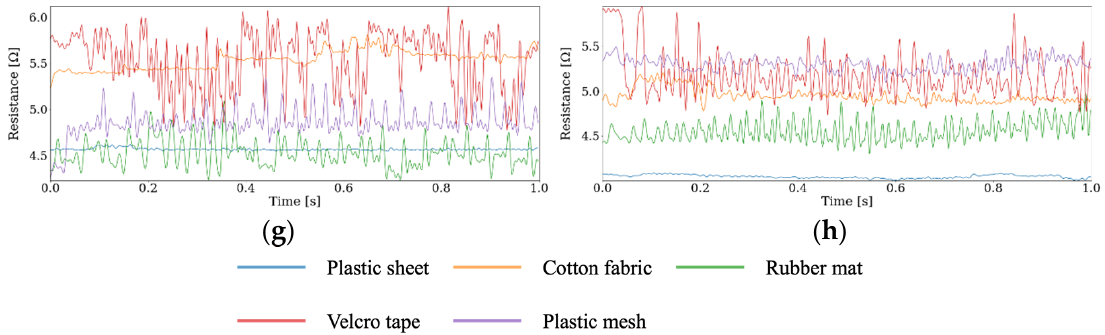
Figure 10. Examples of sensing data with different stroking speeds: ( a ) sliding speed 1 cm/s, ( b ) sliding speed 3 cm/s, ( c ) sliding speed 5 cm/s, ( d ) sliding speed 7.5 cm/s, ( e ) sliding speed 10 cm/s, ( f ) sliding speed 12.5 cm/s, ( g ) sliding speed 15 cm/s, ( h ) sliding speed 20 cm/s.